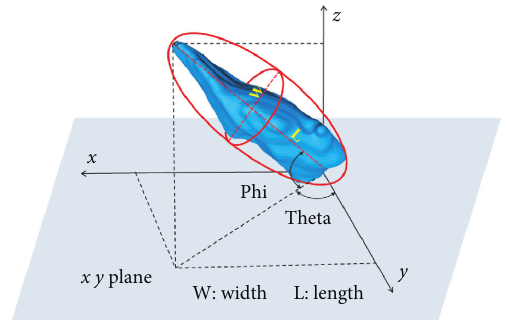
Figure 3: Definition of characteristic parameters for loess